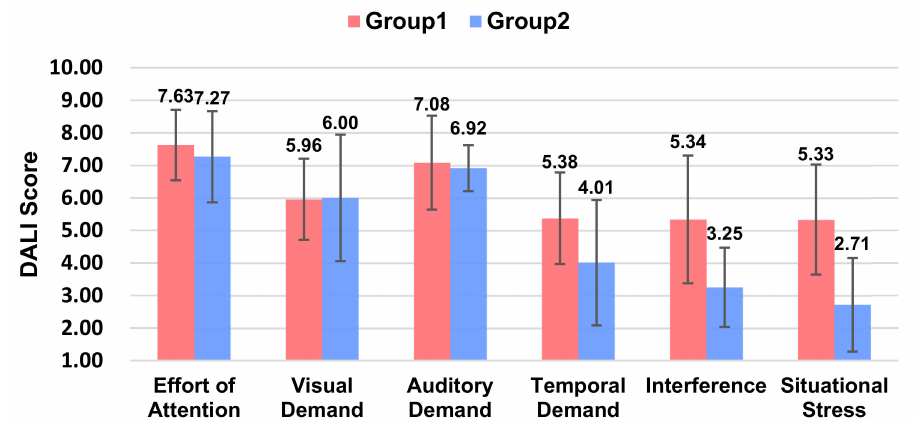
Figure 5. Ratings of the DALI scale between the two groups.